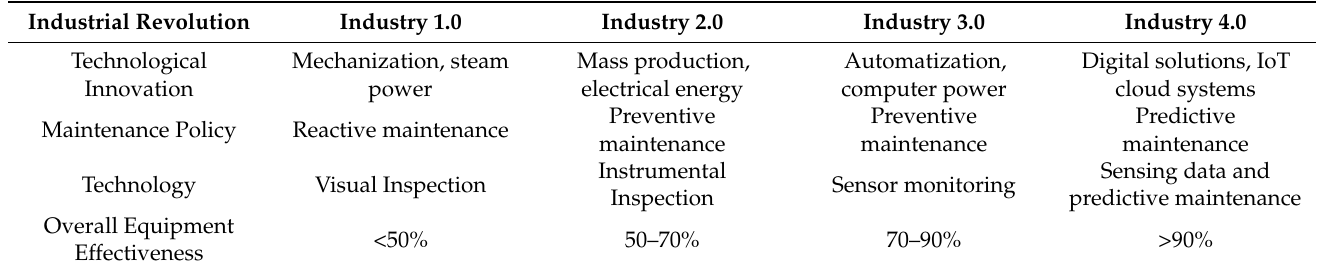
Table 1. The industrial revolution.